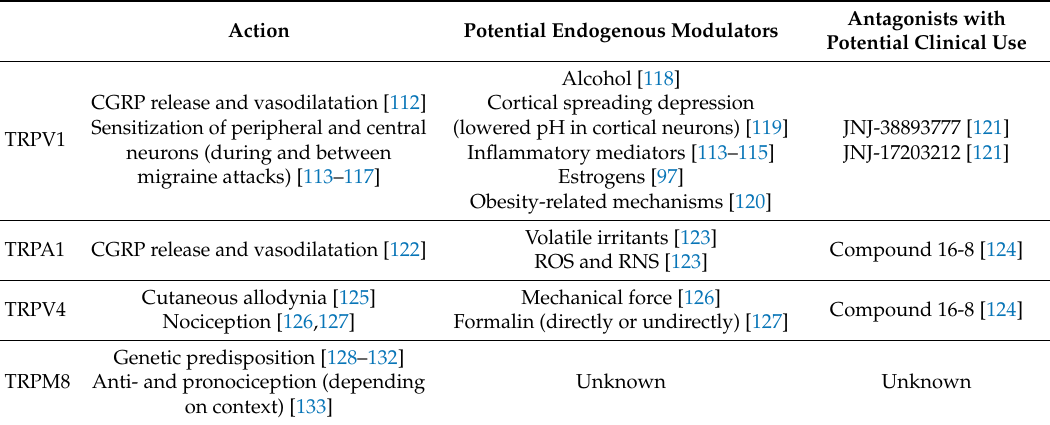
Table 1. Roles of transient receptor potential (TRP) channels in migraine and their potential as therapeutic targets. RNS: reactive nitrogen species, ROS: reactive oxygen species, TRPA1: transient receptor potential ankyrin 1, TRPM8: transient receptor potential melastatin 8, TRPV1: transient receptor potential vanilloid 1, TRPV4: transient receptor potential vanilloid